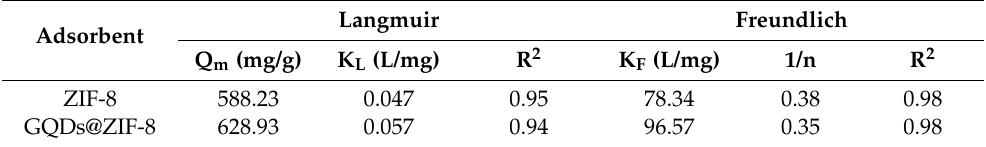
Table 5. Calculated equilibrium constants of the isotherm model for ethyl acetate adsorption. Langmuir Freundlich Adsorbent